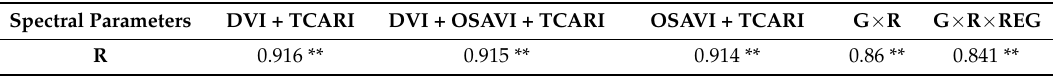
Table 5. Correlation between UAV-based characteristic spectral parameters and SPAD